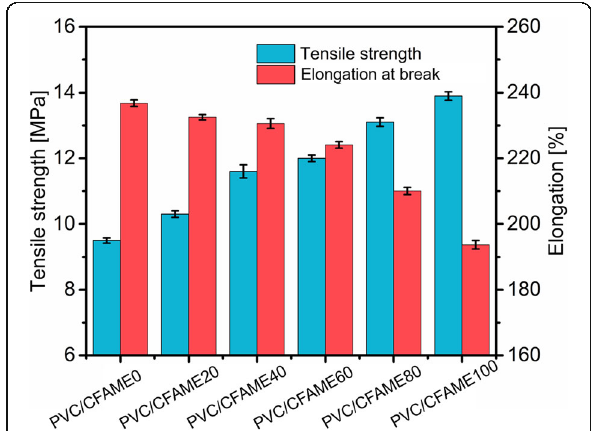
Fig. 9 Tensile strength and elongation at break of the PVC/CFAME x